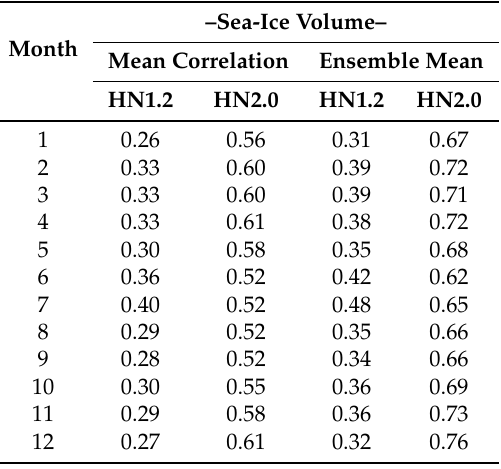
Table 2. Correlation coefficients between the detrended monthly time series of the simulated sea-ice volume and the PIOMAS sea-ice volume. The term “Mean correlation” indicates the mean correlation coefficients between PIOMAS and each of the 10 individual ensemble members; the term “Ensemble mean” indicates the correlation coefficients between PIOMAS and the ensemble mean time series.